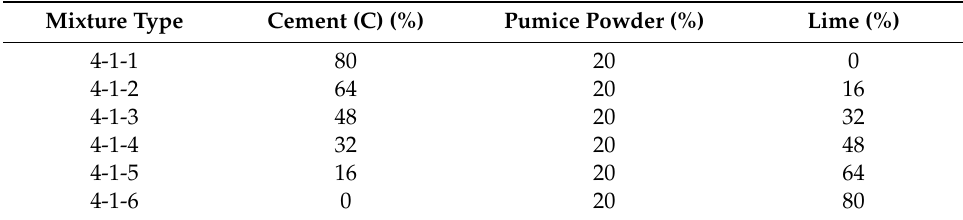
Table 7. Type-4-1 mixing ratios.